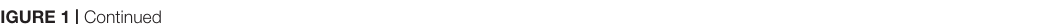
FIGURE 1 | Continued of µ CT scans of Ankrd11 ctrl (Ankrd11 wt / fl ) and Ankrd11 nchet mice. Top panel: lateral view of whole skull. Middle panel: Superior view of frontal bone; mandible and cranial base are clipped out of plane. Red dotted line indicates plane of sectioning for lower row of panels. Yellow dotted line highlights calvarial defect surrounding posterior frontal suture in Ankrd11 nchet mice. Yellow arrows point to regions of hard tissue anomalies in Ankrd11 nchet frontal bone. Lower panels: orthogonal slice through posterior frontal suture indicating pterygoid abnormalities (orange arrow) and open posterior frontal suture (yellow arrow). Inset in lower right corner of images is high contrast representation of cranial base structures affected in image. pb, parietal bone; fb, frontal bone; nb, nasal bone; post. fs, posterior frontal suture. (D) Mesh morphometric analysis of three Ankrd11 nchet mouse skulls. Images shown are a mean mesh of three Ankrd11 nchet skulls relative to a mean mesh of five Ankrd11 ctrl skulls. Note: mandibles were excluded from analysis due to the variable position with respect to the skull. Colors depict Procrustes distances between Ankrd11 ctrl and Ankrd11 nchet mean meshes, with blue indicating negative values (Ankrd11 nchet values fall within Ankrd11 ctrl mesh) and red indicating positive values (Ankrd11 nchet values fall outside of Ankrd11 ctrl mesh). White values indicate no changes, meaning the vertices for these anatomical regions in